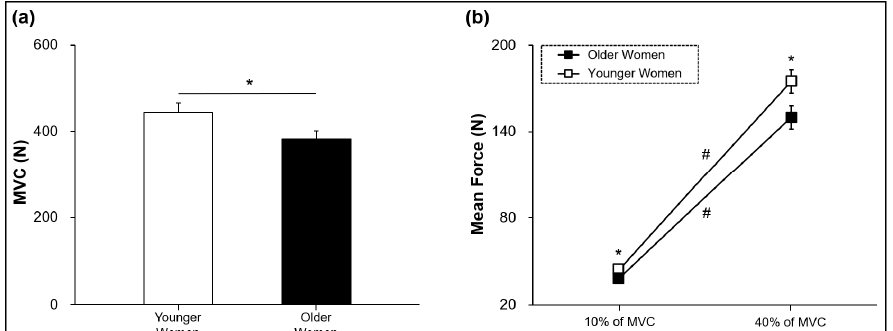
Figure 2. Bimanual maximal and submaximal isometric forces (M ± SE). ( a ) Maximal force showing a significant group main effect. ( b ) Submaximal mean force showing a significant Group × Force Level interaction. Asterisk (*) indicates a significant difference between two groups. Number sign (#) denotes a significant difference between 10% and 40% of MVC.